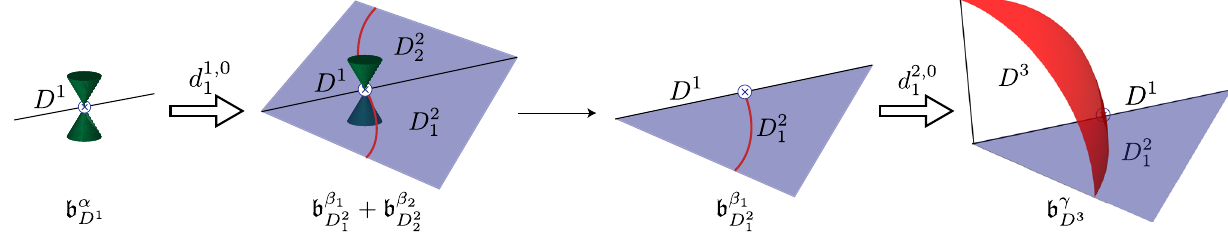
FIG. 12. Illustration of the diagnostic scheme for case A. We begin by acting d 1 ; 0 1 on a generator of E 1 ; 0 1 corresponding to a basis b α Then, we obtain the gapless lines on the 2-cells adjacent to the 1-cell D 1 , which is an element of E 2 ; 0 1 . Next, we focus on one of the adjacent 2-cells. In the figure, we pick D 2 1 from the two 2-cells. In other words, we consider only b β 1 to an element E 3 ; 0 1 by d 2 ; 0 1 and examine whether the mapped element is trivial or we map b β 1 D 2 1